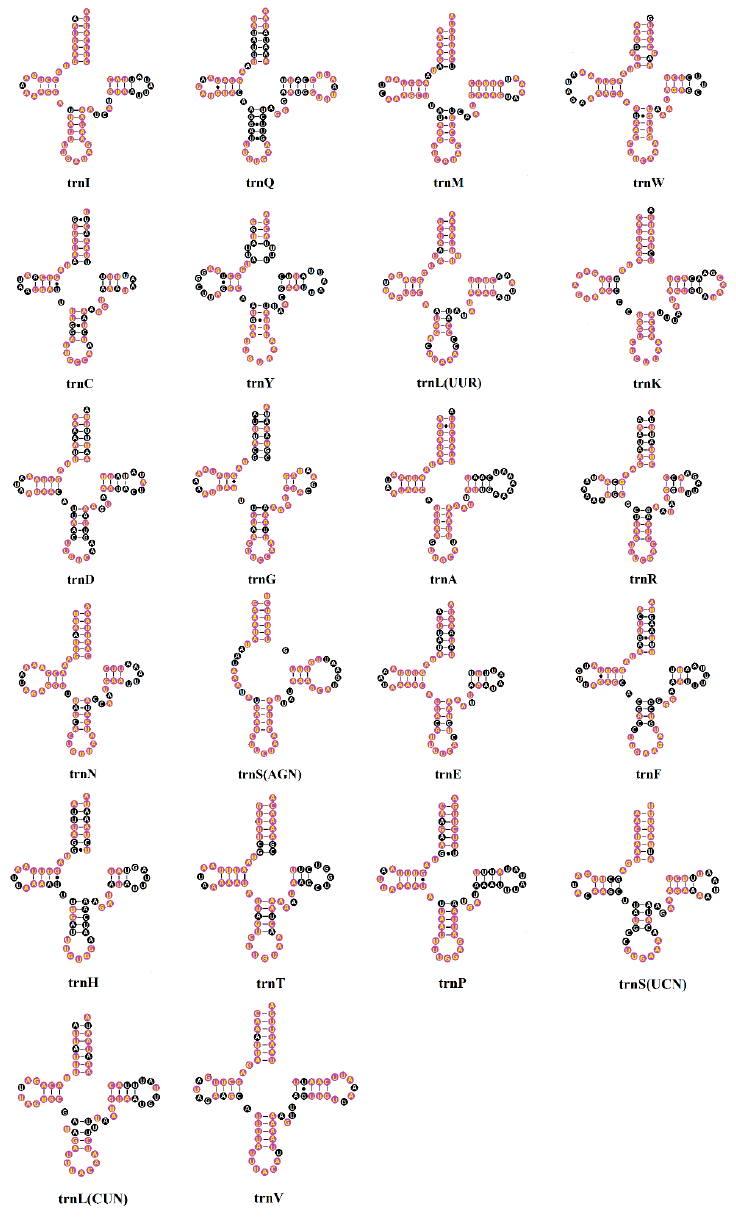
Figure 4. Inferred secondary structures of 22 transfer RNAs (tRNAs) identified in the T. molitor mitogenome. Completely conserved sites within the ten Tenebrionidae specimens were marked by yellow nucleotides within purple spheres. Bars denote Watson-Crick base pairings, and dots denote G-U base pairings.